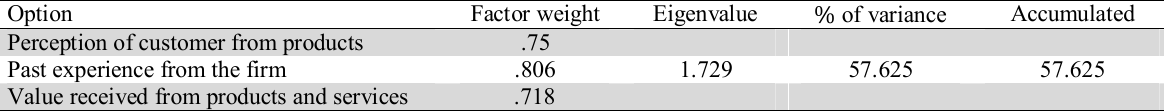
The summary of different components associated with organizational learning Option Factor weight Eigenvalue Perception of customer from products